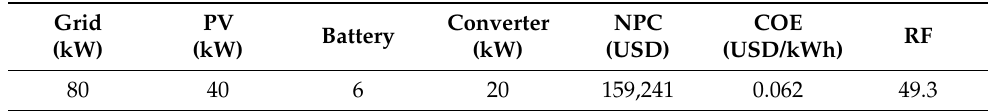
Table 9. Financial features of the grid/PV/battery